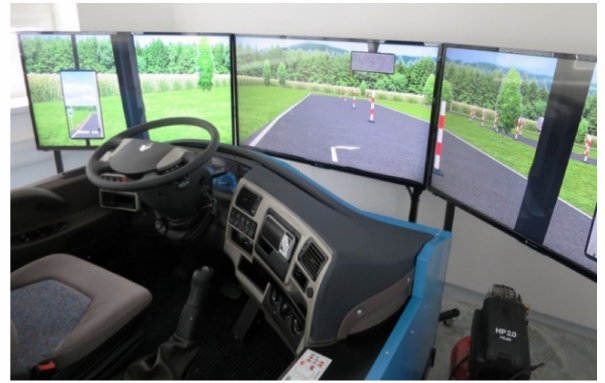
Figure 1. Training driving simulator in SNA–211 REN. Source: Processed by authors.